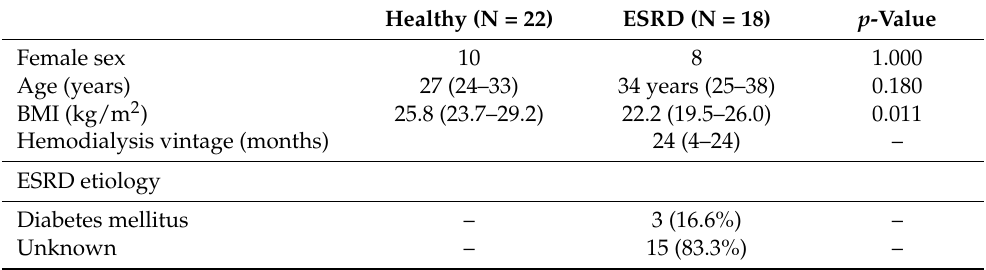
Table 1. Anthropometric and clinical characteristics of healthy and ESRD patients. Data shown as absolute frequency (percentage of relative frequency) or median (interquartile